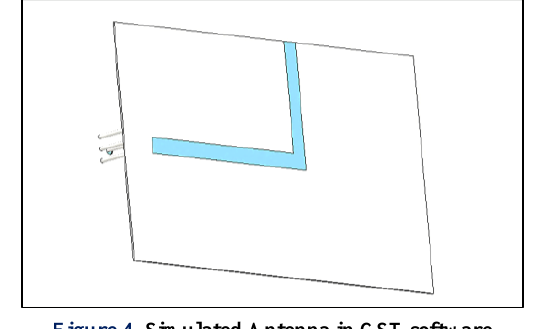
Figure 4. Simulated Antenna in CST software Table 2. Exact value of antenna parameters